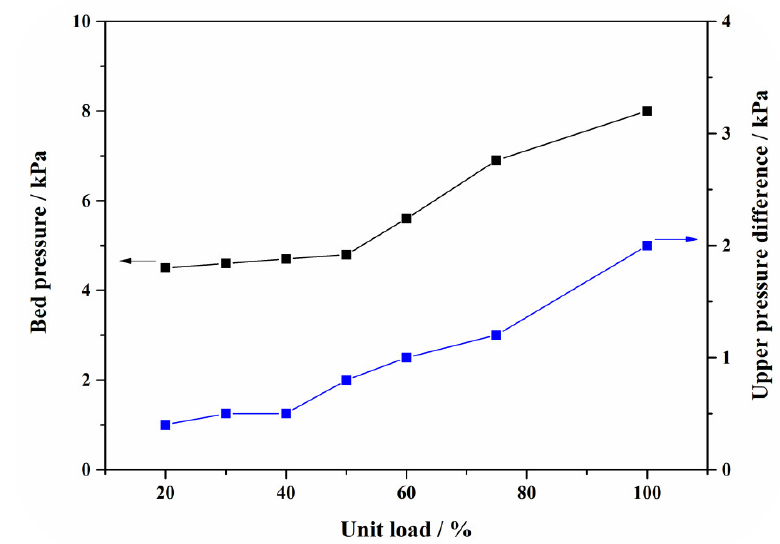
Figure 7. Boiler bed pressure varies with the load.